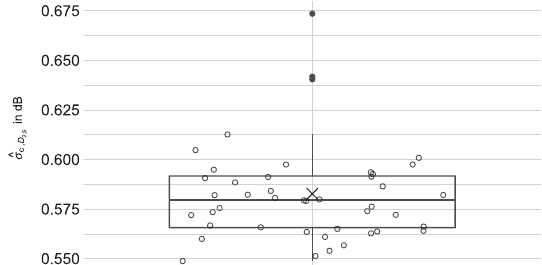
Figure 3. Boxplot of ^ r c ; D for all 44 measurement paths. The 2 ; S results of the individual calculations are indicated as circles, the mean value is represented by x . Three possible outliers are